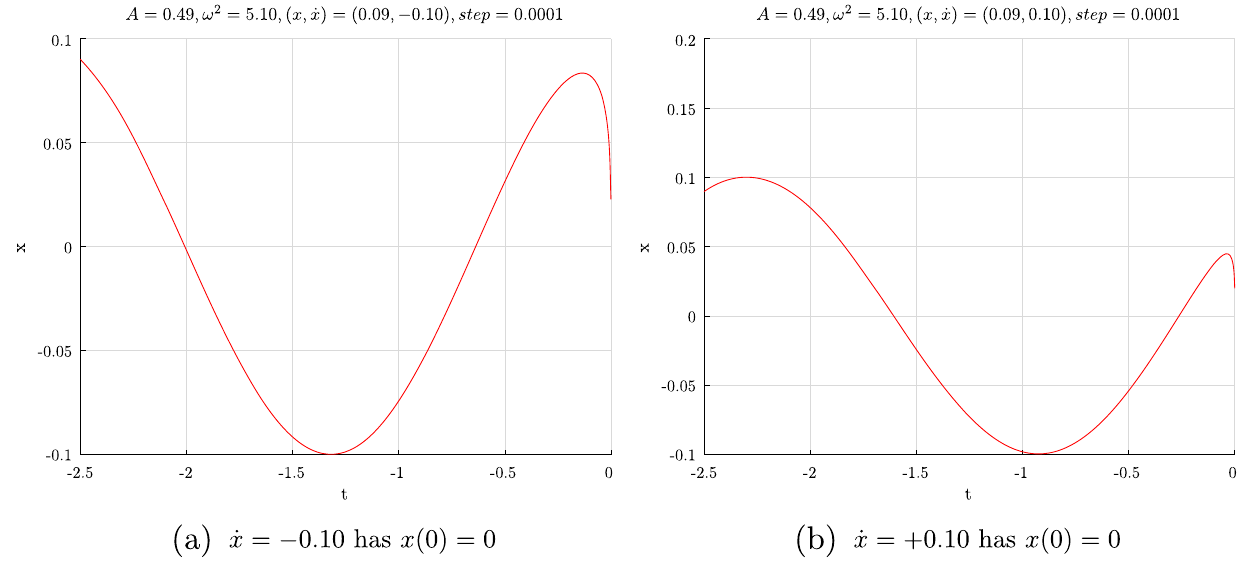
Fig. 2 Classical motion for L B with A < 1 has only one possible asymptotic